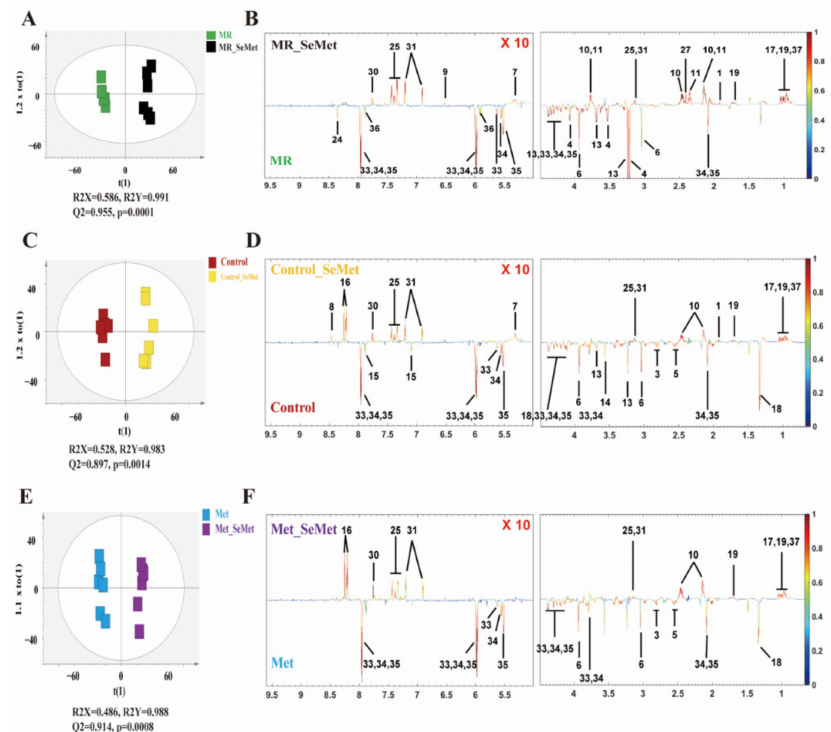
Figure 4. OPLS-DA scores plots ( left ) and corresponding loadings plots ( right ) derived from the 1 H NMR data for HepG2 cell extracts: ( A ) Scores plot of the model constructed between MR and MR_SeMet groups; ( B ) Loading plot of changed metabolites between MR and MR_SeMet groups; ( C ) Scores plot of the model constructed between control and control_SeMet groups; ( D ) Loading plot of changed metabolites between control and control_SeMet groups; ( E ) Scores plot of the model constructed between Met and Met_SeMet groups; ( F ) Loading plot of changed metabolites between Met and Met_SeMet groups. Keys: 1. Acetate; 3. Aspartate (Asp); 4. Choline; 5. Citrate; 6. Creatine; 8. Formate; 9. Fumarate; 10. Glutamate (Glu); 11. Glutamine (Gln); 13. Glycerophosphocholine (GPC); 14. Glycine (Gly); 15. Histidine (His); 16. Hypoxanthine; 17. Isoleucine (ILe); 18. Lactate; 19. Leucine (Leu); 24. Nicotinamide Adenine Dinucleotide (NAD); 25. Phenylalanine (Phe); 27. Succi- nate; 30. Tryptophan (Trp); 31. Tyrosine (Tyr); 33. UDP-Glucuronate; 34. UDP-N-acetylgalactosamine; 35. UDP-N-acetylglucosamine; 36. Uridine; 37. Valine